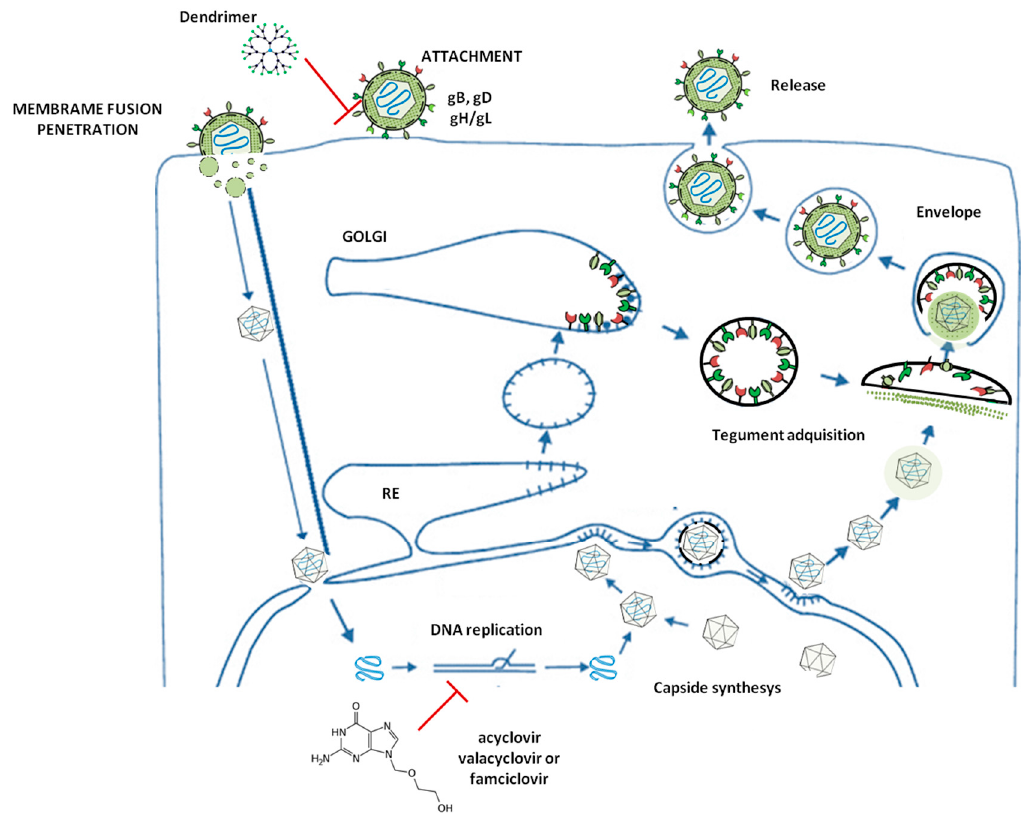
Figure 1. The infective cycle of HSV-2. Schematic representation of the HSV-2 infective life cycle and the possible steps where antivirals can perform their action.